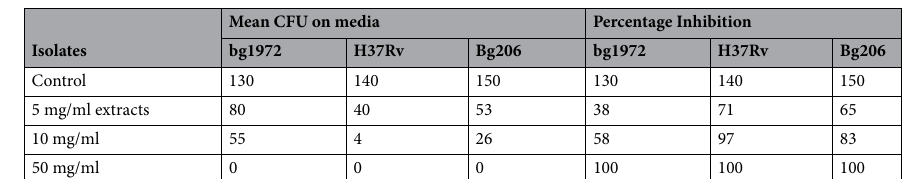
Table 10. Anti-tuberculosis activity of DV Methanol against different strains. % Inhibition = Ccn − Ct/ Ccn × 100, where Ccn = no of colonies in the control media slope, Ct = No of colonies in the Test media slope.